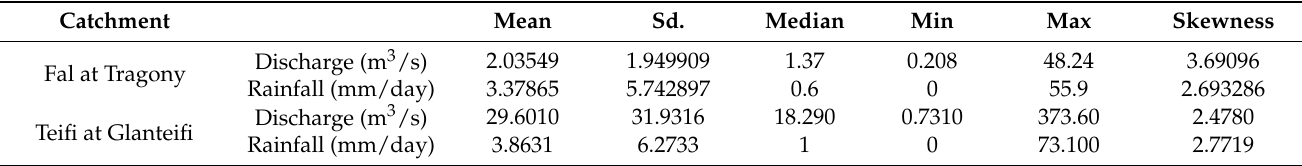
Table 2. Statistics of dataset from two